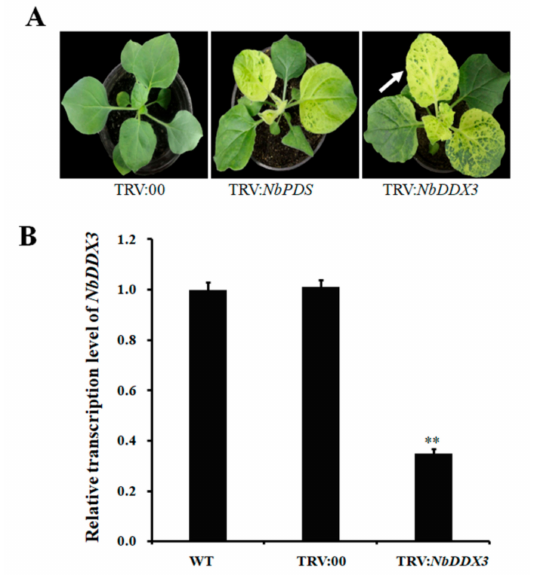
Figure 4. Silencing of the N. benthamiana NbDDX3 gene. ( A ) Growth phenotypes of NbDDX3- silenced plants at 15 dpi. White arrows indicate leaf mottling in NbDDX3-silenced plant. ( B ) qRT-PCR analysis of the transcript level of the NbDDX3 gene at 15 dpi. The expression of NbEF1 α was used as an internal control. The expression level in wild type plants was set to “1” and the fold change in silenced plants was calculated by comparison with wild type. Error bars indicate standard deviations, and asterisks denote statistical significance (** p < 0.01, n = 3). All experiments were repeated three